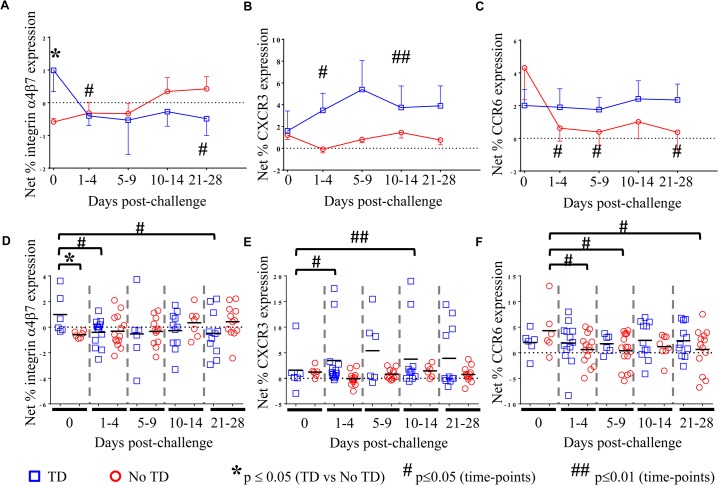

S. Typhi-specific homing potential of circulating Treg.Net S. Typhi-specific expression of A) integrin 47, (TD n = 6, No TD n = 6) B) CXCR3, (TD n = 6, No TD n = 6) C) CCR6 (TD n = 6, No TD n = 6) Values are shown as the mean +/- SEM. Scatter plots showing the net expression of D) integrin α4β7, E) CXCR3, and F) CCR6 on S. Typhi-specific Treg. Means are indicated with a black horizontal line. Time points with statistically significant differences between TD and No TD volunteers (*) or among time-points within each group (#) are identified. P-values were determined using a mixed effects regression model. TD (blue squares); No TD (red circles). Values from multiple time-points were grouped together in time segments (1–4, 5–9, 10–14, and 21–28 days post-challenge) to account for variability in the numbers of samples available from each volunteer. Some volunteers had samples from multiple time-points in a time-segment resulting in more data points than the corresponding number of volunteers.